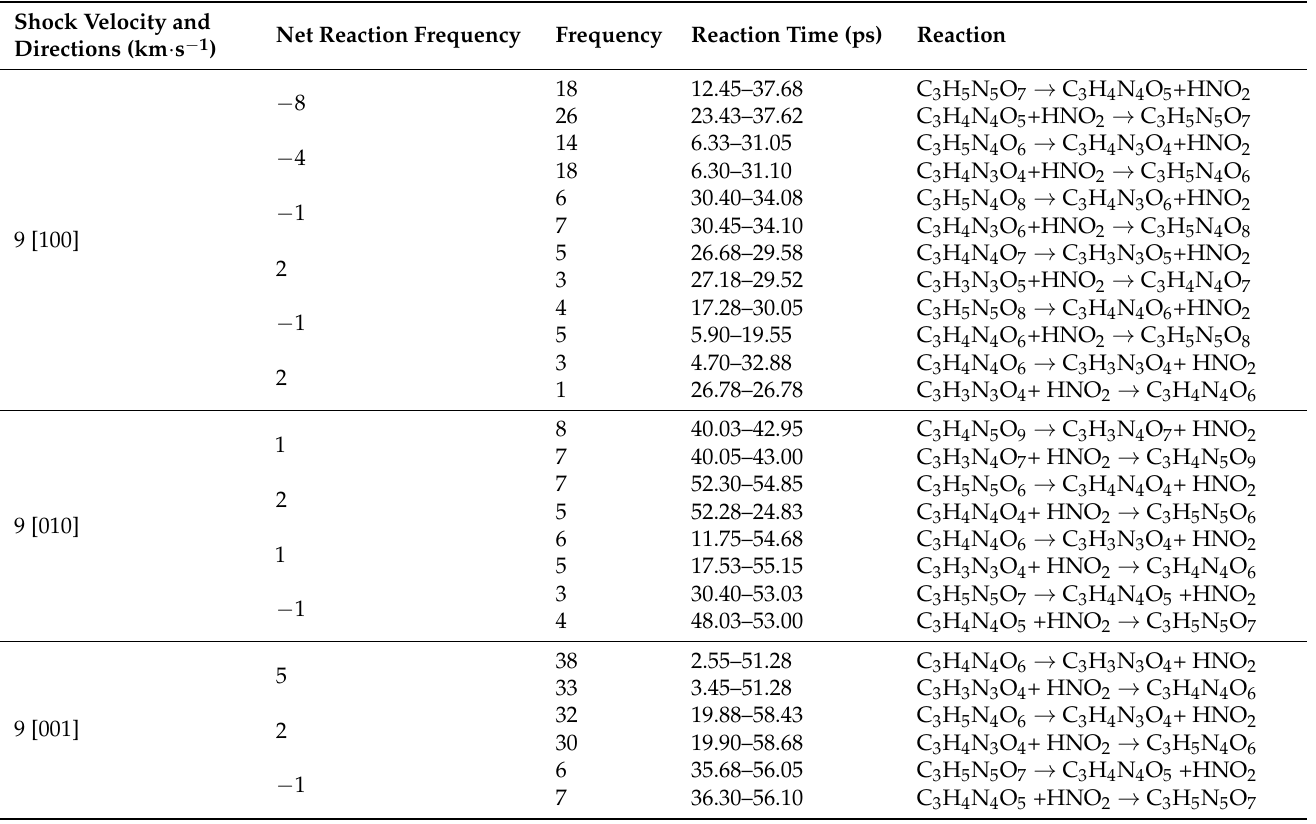
Table 7. Reactions of HNO 2 molecule